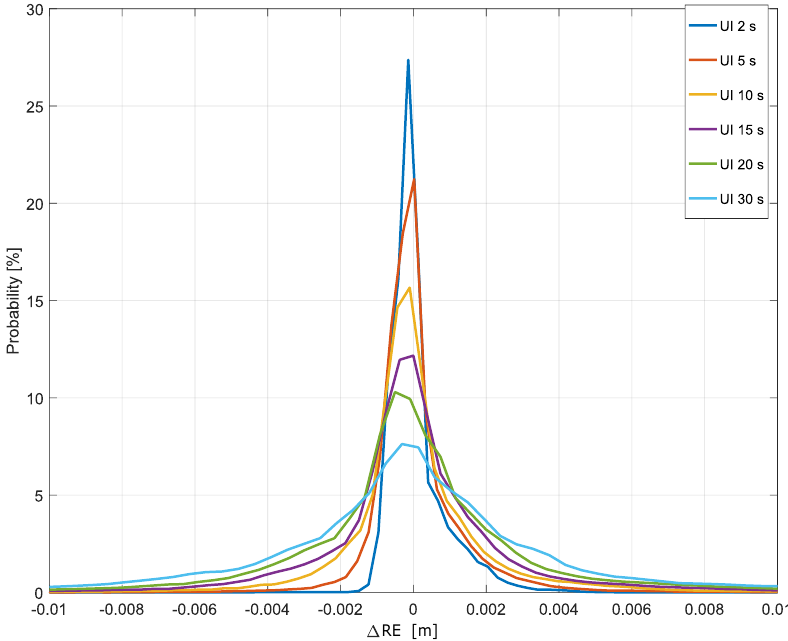
Figure 8. Empirical histograms of the RE differences for different update rates. Histograms have been represented with continuous lines to allow the superposition of different curves. In the legend, “UI” stands for “Update Interval”. The histograms have been computed considering epochs without updated corrections.